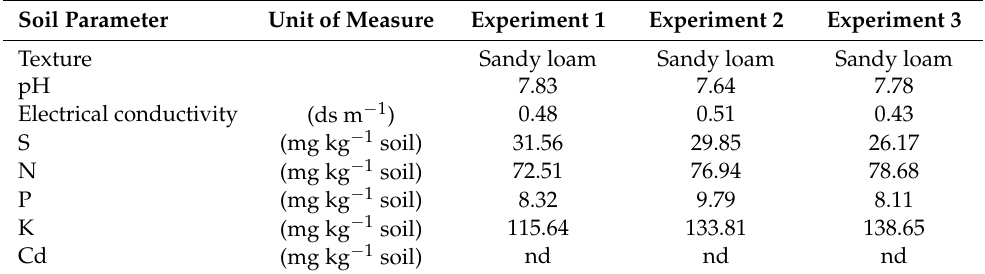
Table 1. Mean values ( n = 4) of physicochemical parameters of soils from experiments 1–3. nd, not